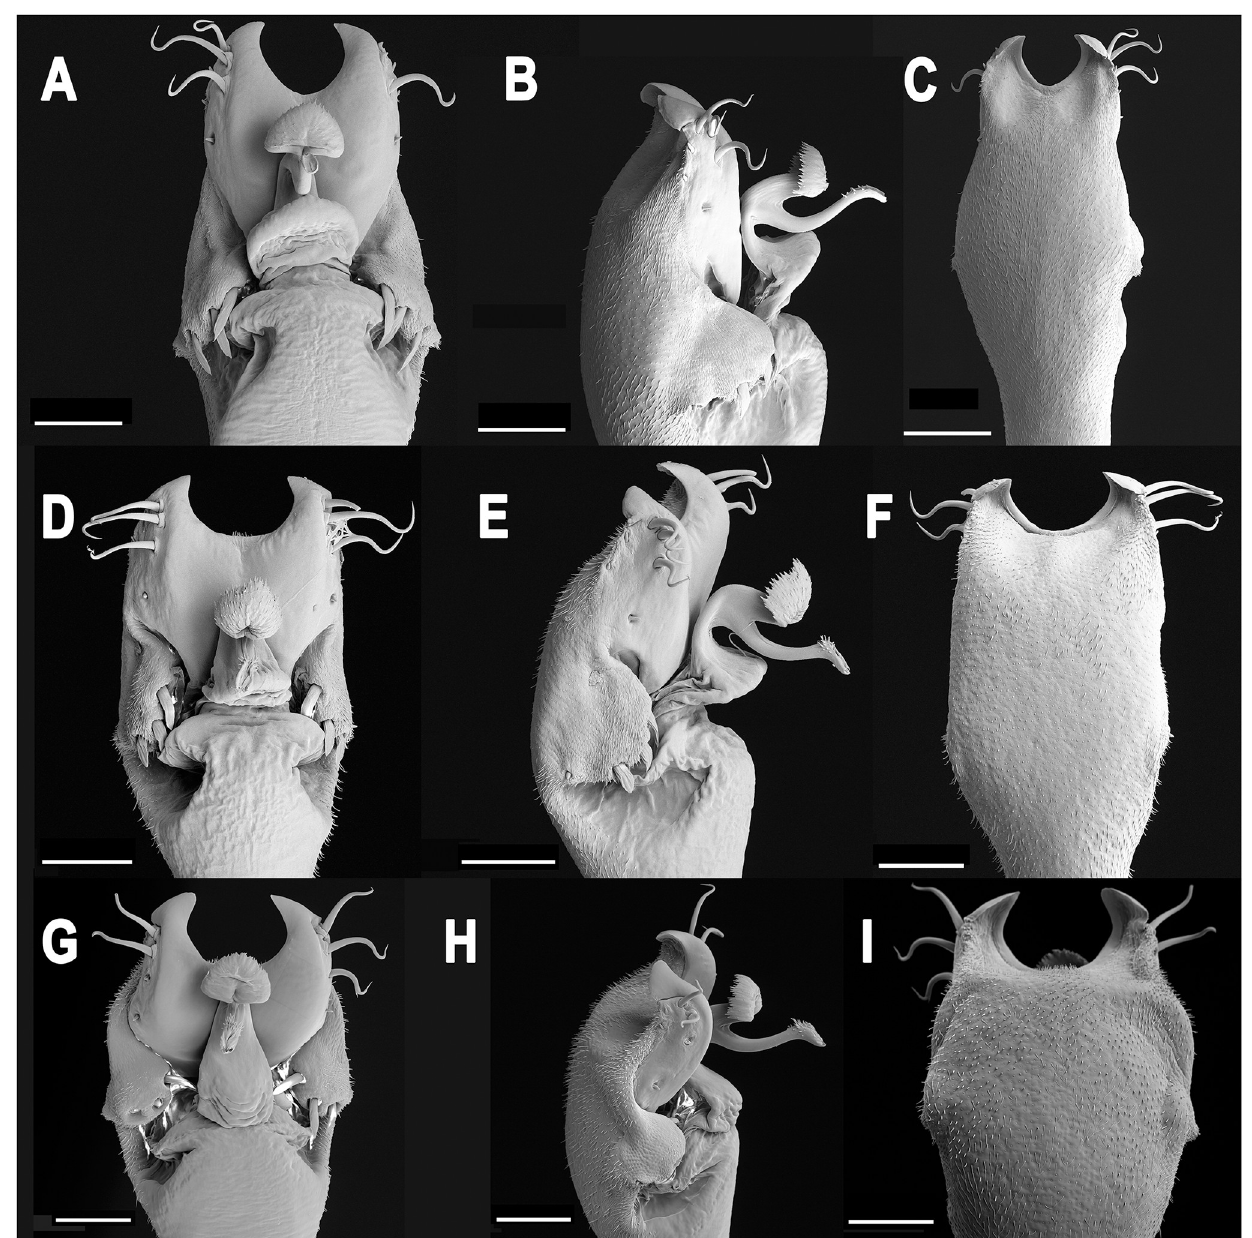
Fig 11. Male genitalia of Neosadocus species. A, D, G: dorsal view; B, E, H: left lateral view; C, F, I: ventral view. A–C. N . bufo (voucher specimen MZSP 76295). D–F. N . robustus (voucher specimen MZSP 76362). G–I. N . maximus (voucher specimen MZSP 76336). Scale bars: 100 μ m.